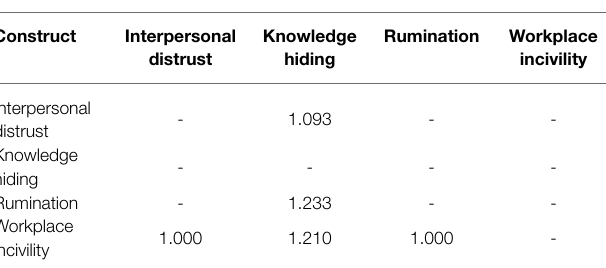
Bold and Italic values are square root of AVE of respective construct. TABLE 3 | Inner model VIF. TABLE 4 | Direct, indirect, and total